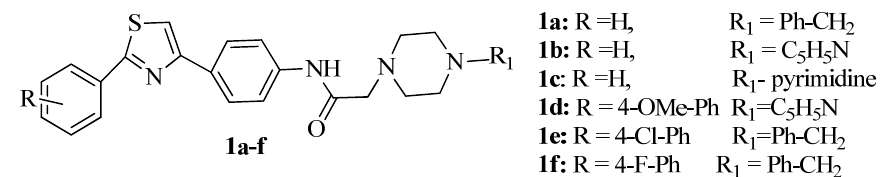
Figure 2. Structure of N-(4-(2-phenylthiazol-4-yl)phenyl)-2-(piperazin-1-yl)acetamide derivatives.